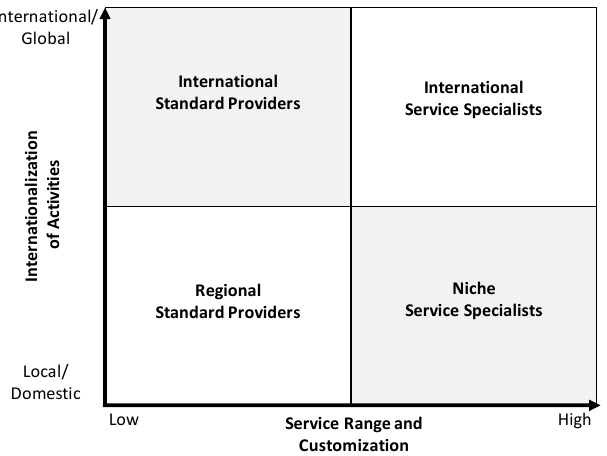
Figure 2. Portfolio of generic third-party logistics (3PL) business models. The business models are differentiated from each other by the provided service range and corresponding customization (horizontal axis) as well as by the degree of internationalization of activities (vertical axis).